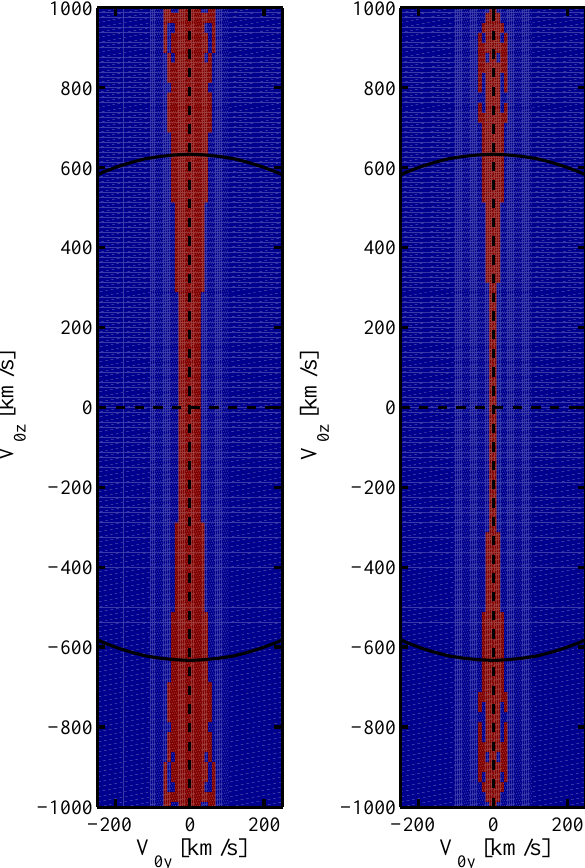
Fig. 13. Two-dimensional scan of the existence domain of a 2000km-wide e − -H + slab as a function of the flow V 0 in the slab for a potential difference 1φ 0 = 0V (left) and 1000V (right) be- tween slab and background. Red corresponds to the region where an equilibrium solution is possible. The circle corresponds to the thermal speed of the slab ions (633kms − 1 ). The magnetic field is oriented essentially along z